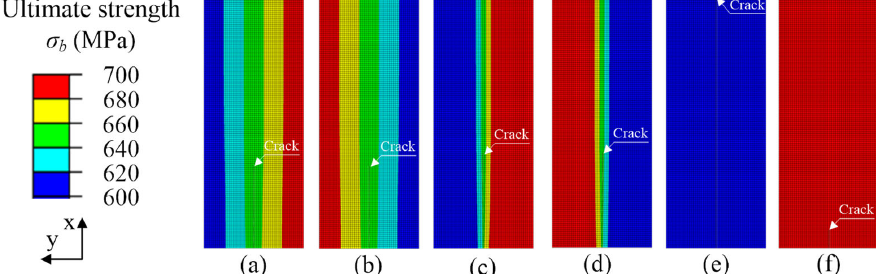
Figure 5. Crack propagation paths and ultimate strength distribution with mismatch coefficients in the y ‐ direction. ( a ) G y = − 50 MPa/mm, ( b ) G y = 50 MPa/mm, ( c ) G y = − 100 MPa/mm, ( d ) G y = 100 MPa, ( e ) σ b,316L = 600 MPa, ( f ) σ b,304 = 700 MPa.